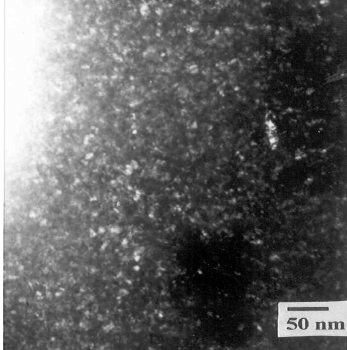
Figure 3. The bright fild TEM image of BaTiO (b) its corresponding selected area diffraction pattern.